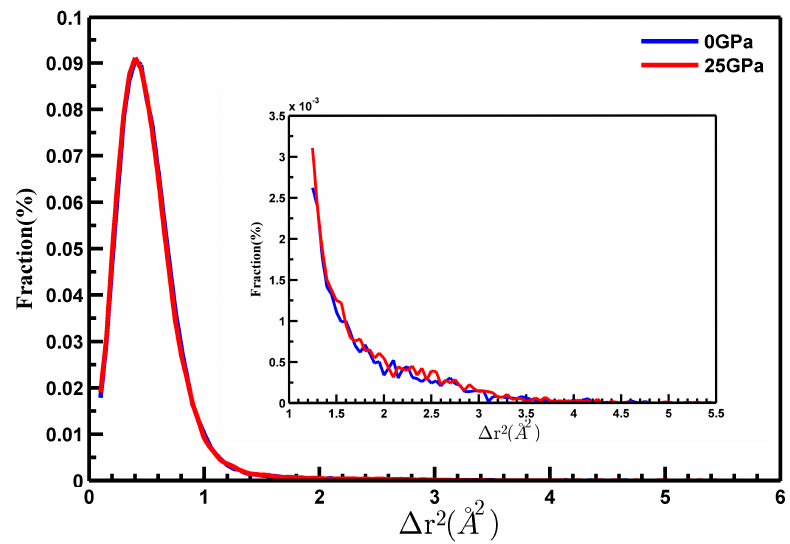
Figure 8. The distribution of mobility of atoms in different samples quenched at different pressures.